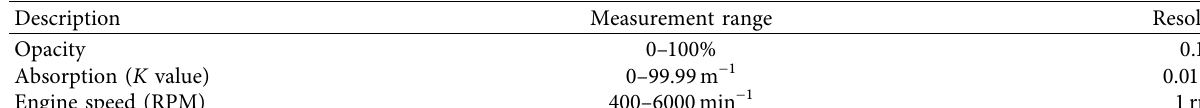
Table 3: AVL smoke meter specifcation details.